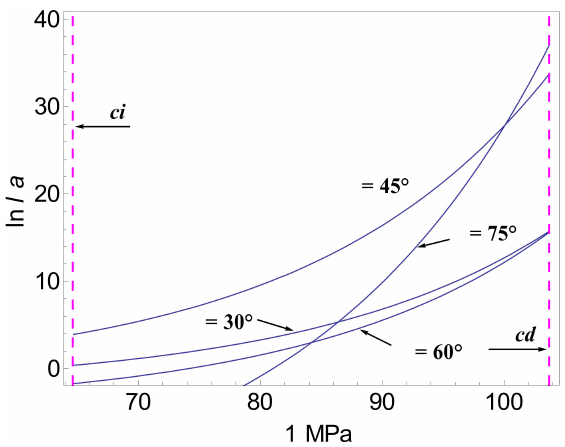
Figure 8. Variation curves of wing crack length during stable crack propagation under different initial crack inclination angles θ ( σ 3 = 0, w = 25 mm, a = 5 mm).